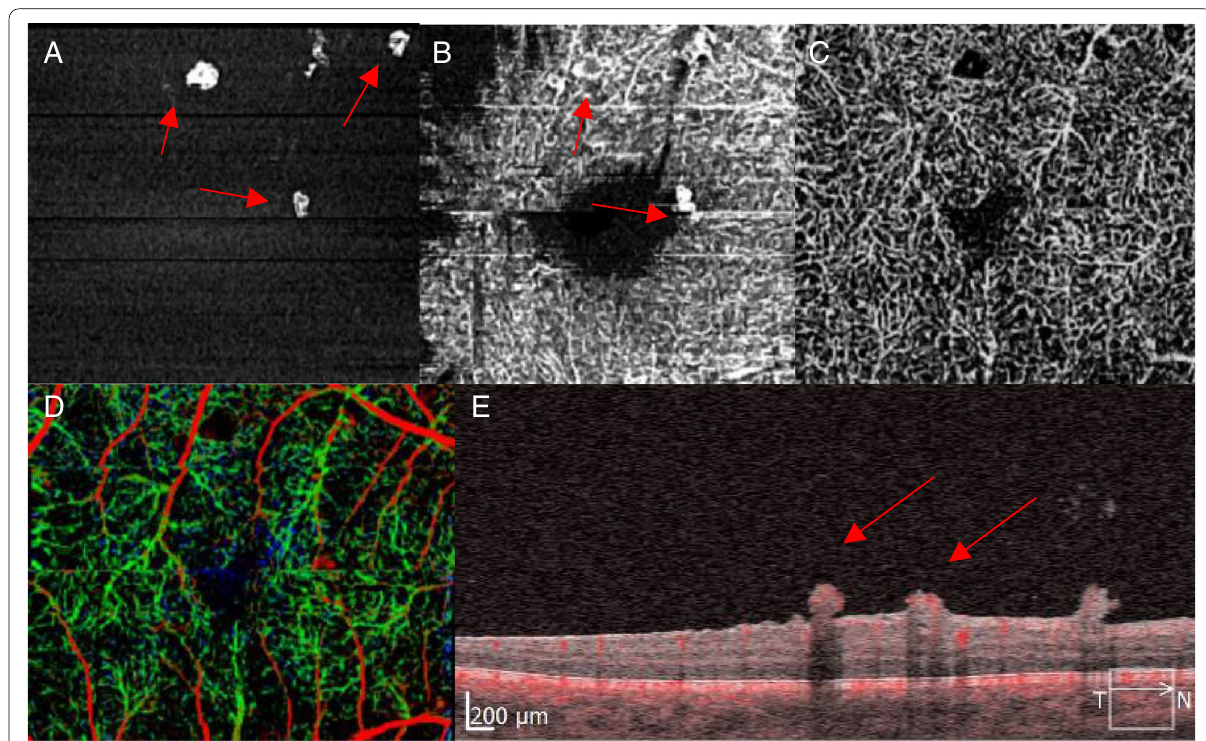
Fig. 3 OCTA of the right macula showing the tiny epiretinal neovascular tufts extending towards the vitreous ( A , B ) (arrows). These ERN arise from the superficial retinal capillary plexuses, as seen on the superficial retinal slab then disappear when moving down to the deep retinal slab ( C ). The depth‑coded view and corresponding B‑scan show flow signal through the ERNs, and the signal extends above the ILM (arrows) ( D , E